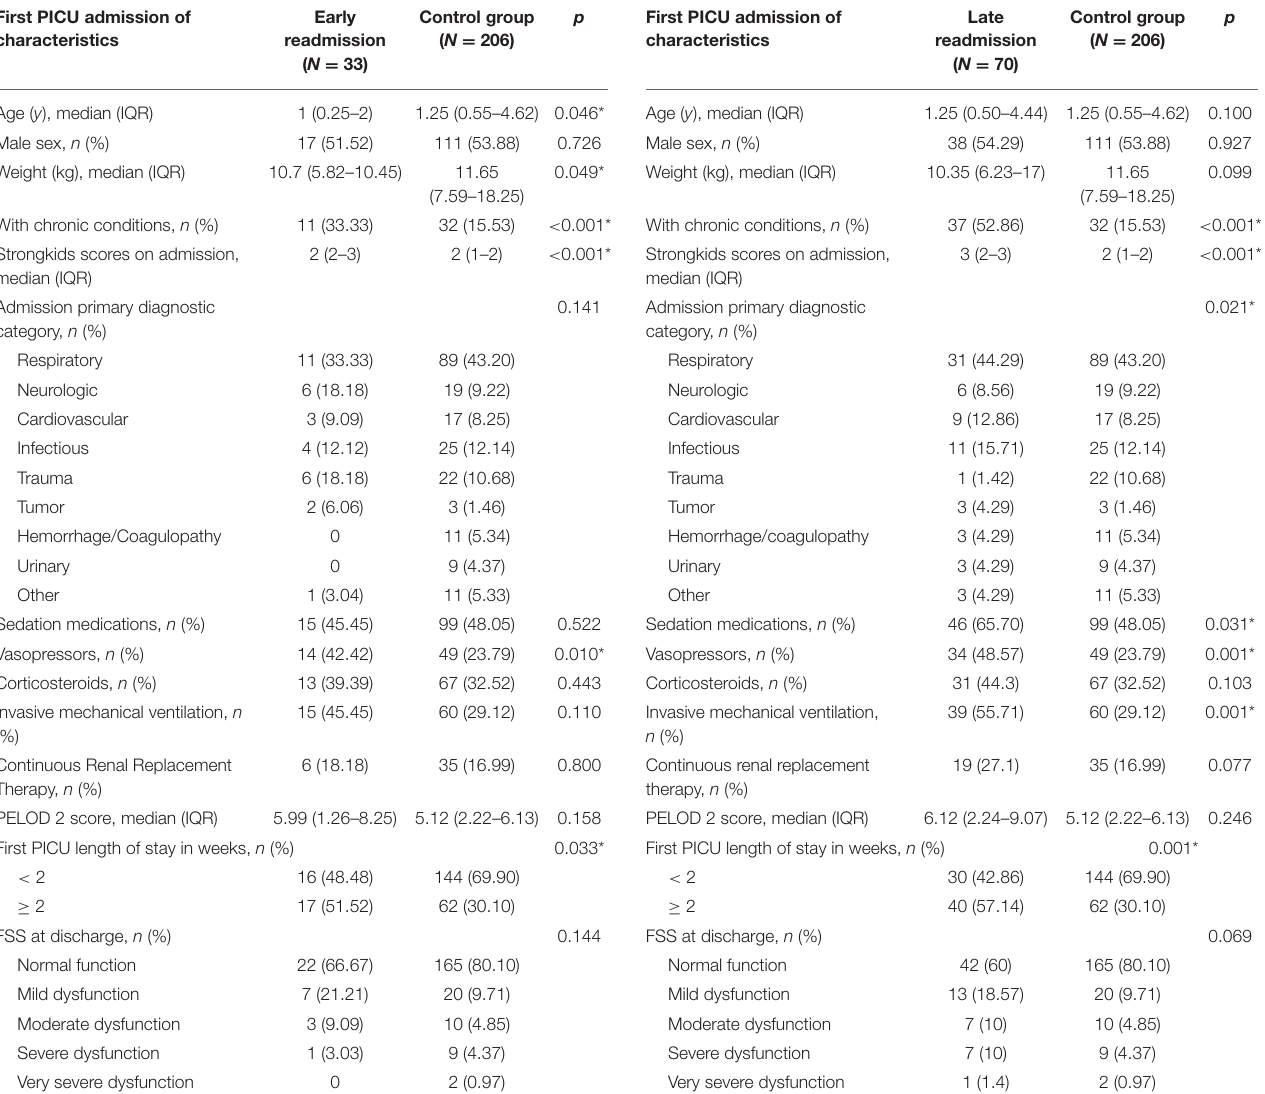
TABLE 3 | Risk factors of early readmission associated with characteristics on first PICU admission.